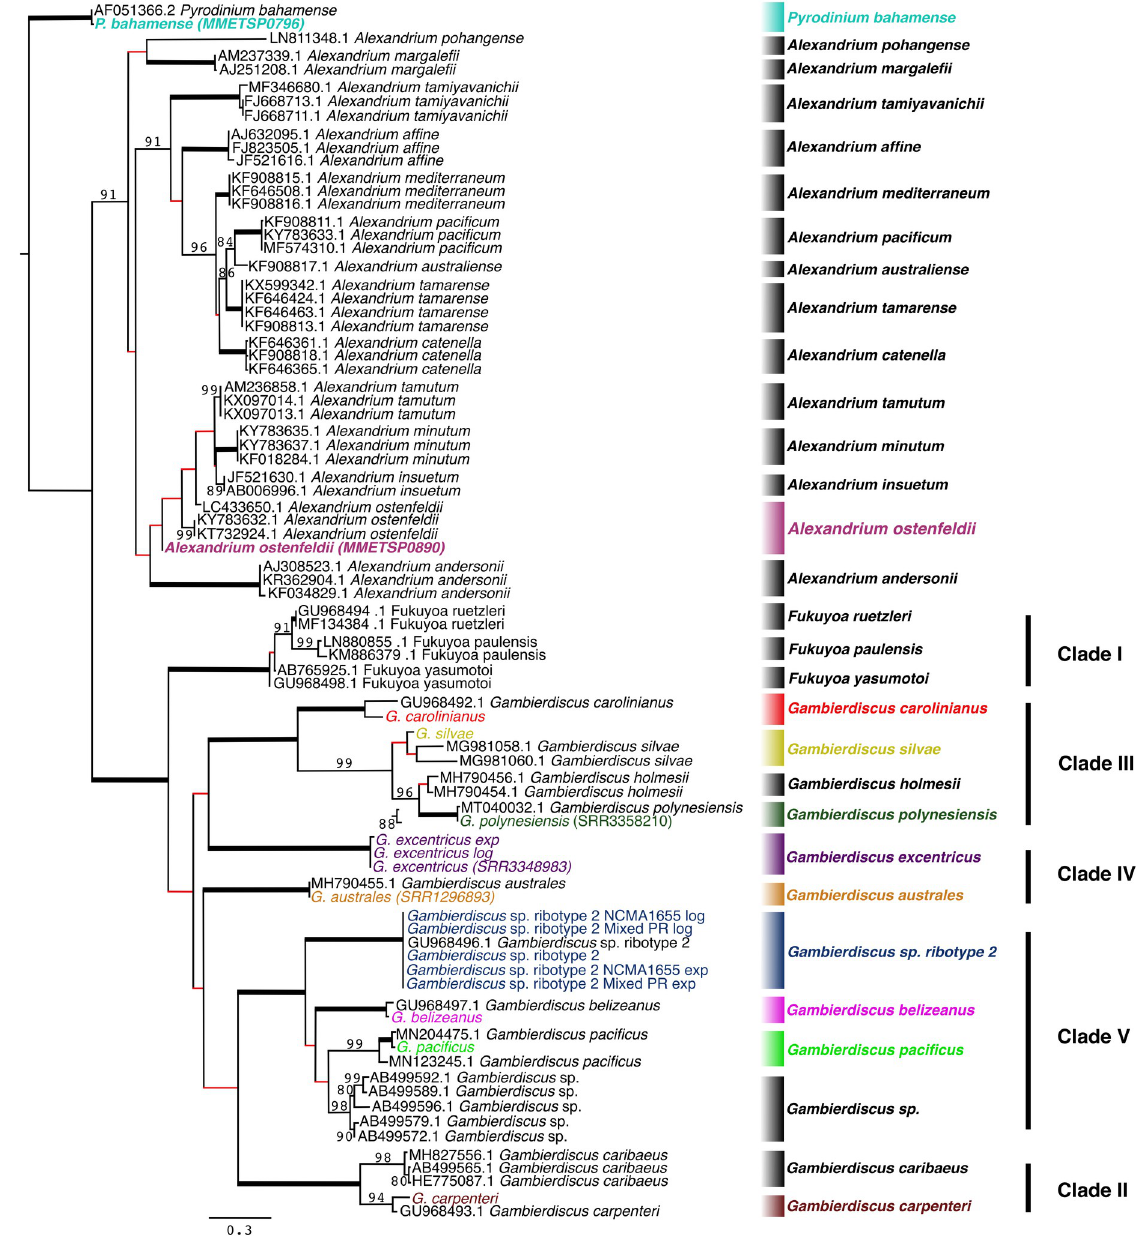
Fig 2. Gambierdiscus , Fukuyoa and Alexandrium ITS/5.8S phylogeny. Maximum likelihood tree (generated by RAxML). Branches indicated in red are not supported (ML bootstrap � 80%). Bolded taxa are sequences obtained from high-throughput transcriptomics. Those with an identifier following the name resulted from transcriptomes pulled from NCBI. Nucleotide tree with 81 taxa. There are 0.3 substitutions per site. phylogenies, Clade III was ancestral to clades II, IV and V with placement of Clade II being ambiguous. In 28-gene phylogeny, Clade II, represented by G . carpenteri , was most closely associated with Clade IV, consistent with the D1-D3 phylogeny (Fig 3). The 17-gene phylogeny showed Clade II as intermediate between IV and V but with weak branch support (Fig 4). The inclusion of transcriptomic data from G . caribaeus , the other Clade II species, may be required